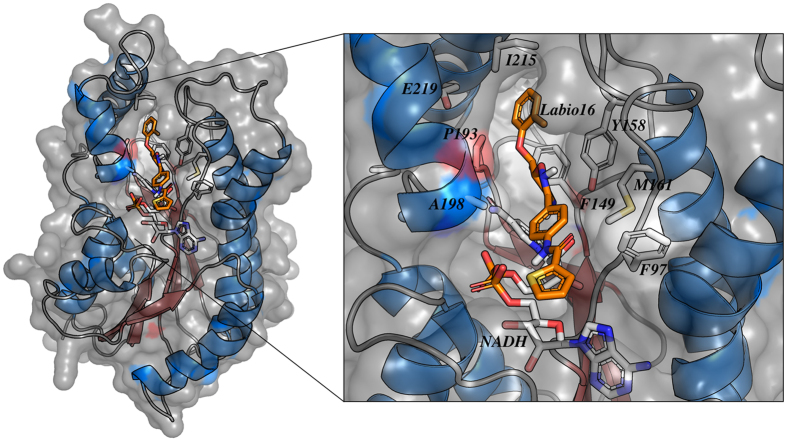
Intermolecular interactions between Labio_16 compound and MtInhA:NADH binary complex.The in silico binding mode of Labio_16 was obtained from the docking experiment. The residues represented as sticks, including NADH, are involved in the stabilization of the compound Labio_16 in the substrate binding cavity. Image prepared with PyMOL40.